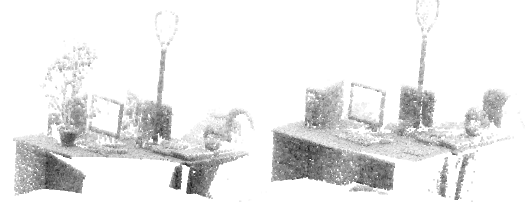
Figure 3: TLS dataset, with two points of view, colored using ambient occlusion.